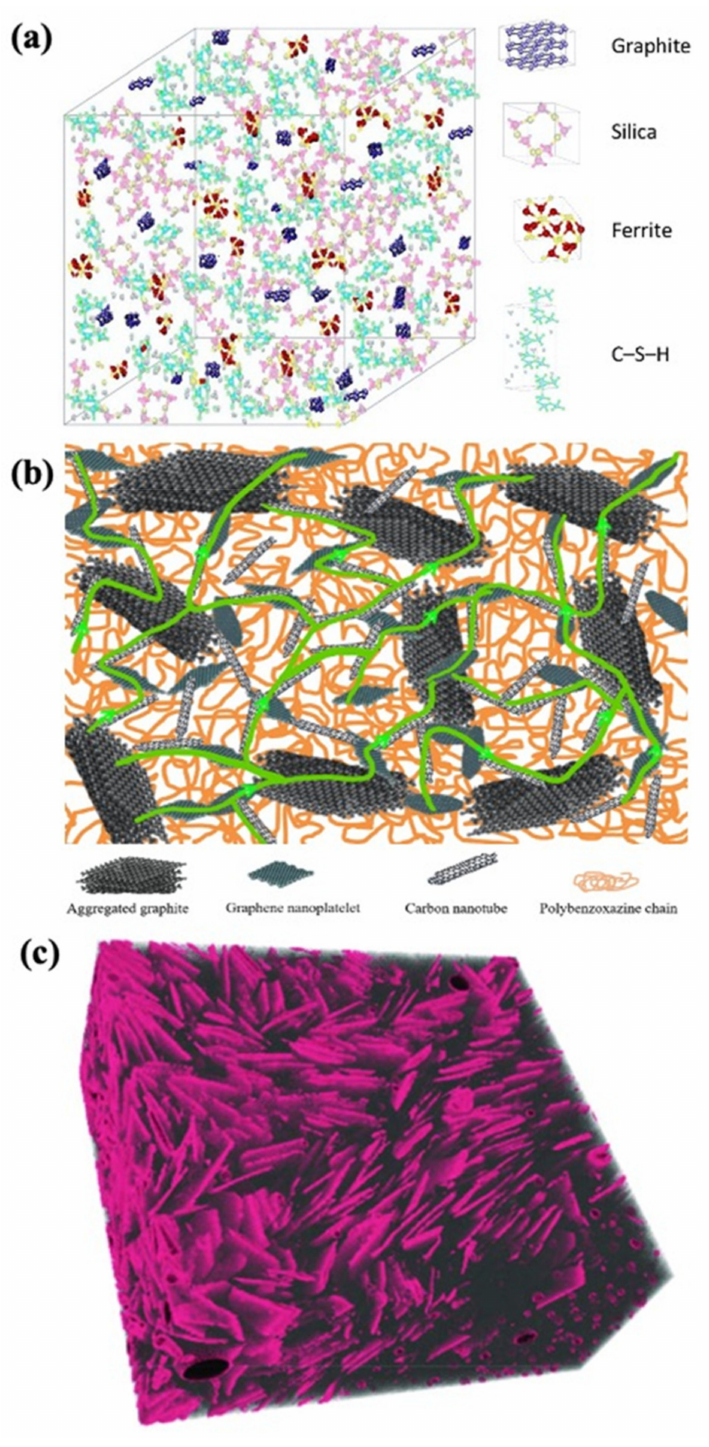
Figure 9. ( a ) conductive concrete mechanism (reprinted (adapted) with permission from [87] ©2021 with permission from Elsevier); ( b ) thermal conduction path (reprinted (adapted) with permission from [93] ©2020 with permission from Elsevier); ( c ) graphite flakes (pink) dispersed in matrix (gray), 3D reconstructed image of specimen (reprinted (adapted) from [3] which is an open access article and permits unrestricted